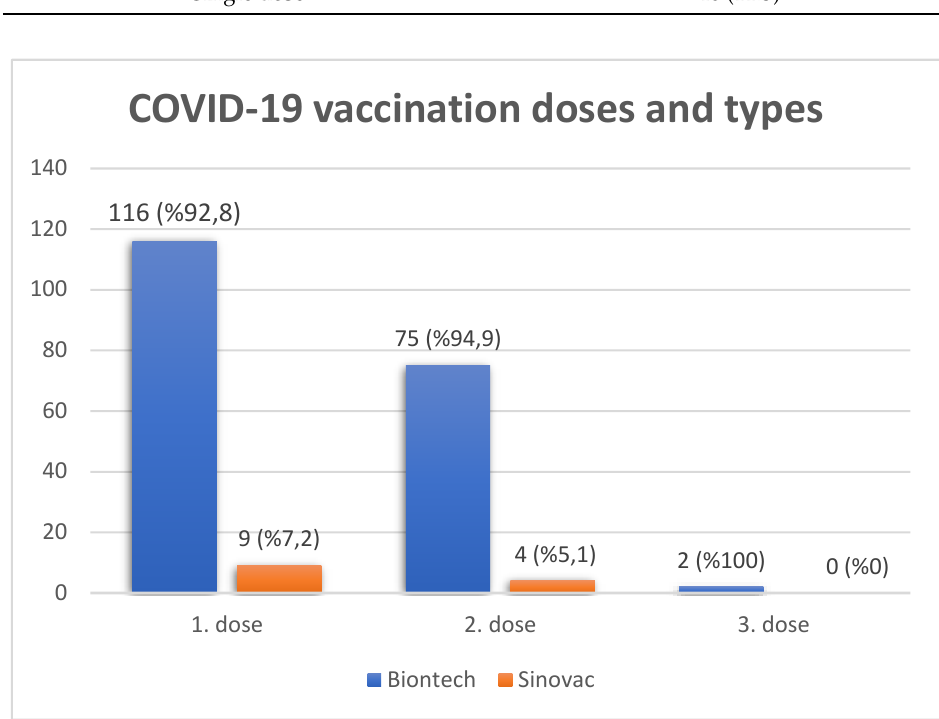
Figure 1. COVID-19 vaccination doses and types. No women were vaccinated with Turkovac. Of the pregnant women, 17 (4.2%) had been infected with COVID-19 during their pregnancy. None of these women were fully vaccinated against COVID-19. There were two pregnant women hospitalized due to COVID-19 infection, but none of the hospital- ized women were intubated. The history of COVID-19 infection during pregnancy and pregnancy trimesters of the PCR-positive pregnant women are shown in Table 3. Table 3. History of COVID-19 infection during pregnancy and pregnancy trimesters of PCR-posi- tive pregnant women .